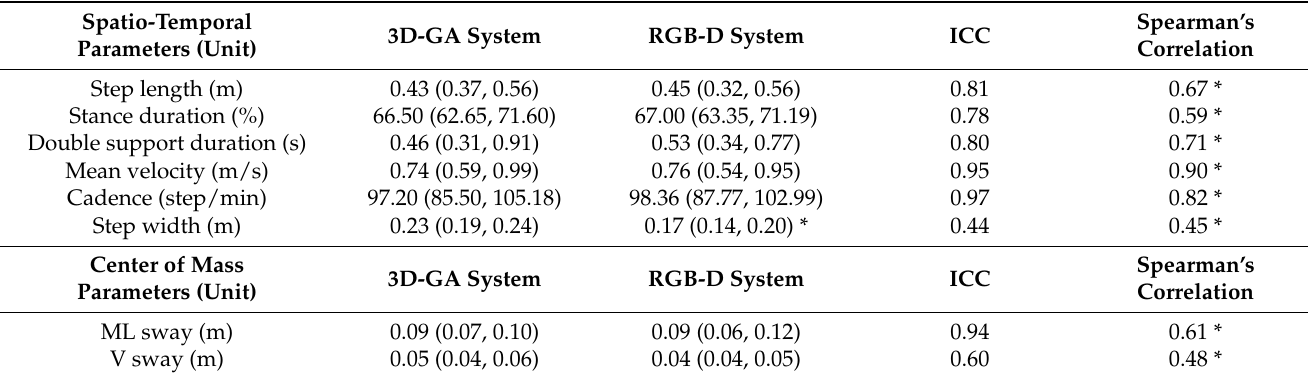
Table 1. Median (first and third quartile) values for spatio-temporal and COM parameters estimated for the two systems, ICC and values of Spearman’s correlation coefficient between the 3D-GA and RGB-D system (*: p <